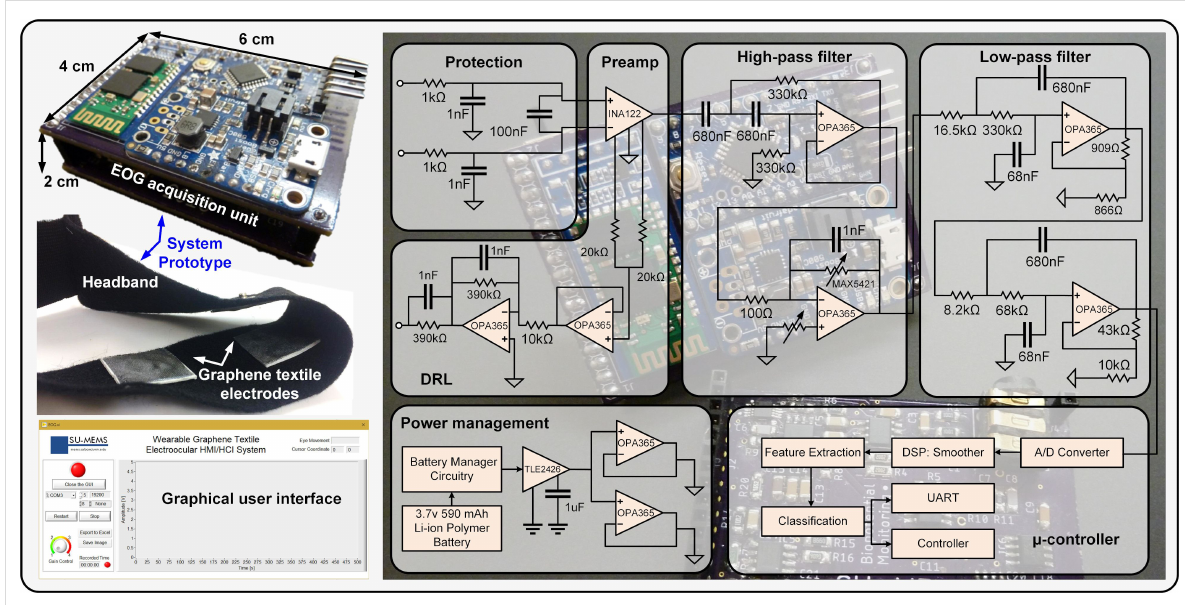
Figure 2: Overview of the system prototype showing the detailed hardware-level schematic of the portable, battery-powered, EOG acquisition unit in- cluding on-board filtering and gain stages, power management section, microcontroller unit to process and stream data wirelessly to a computer along with a custom-designed user interface, and the wearable headband with soft graphene textile